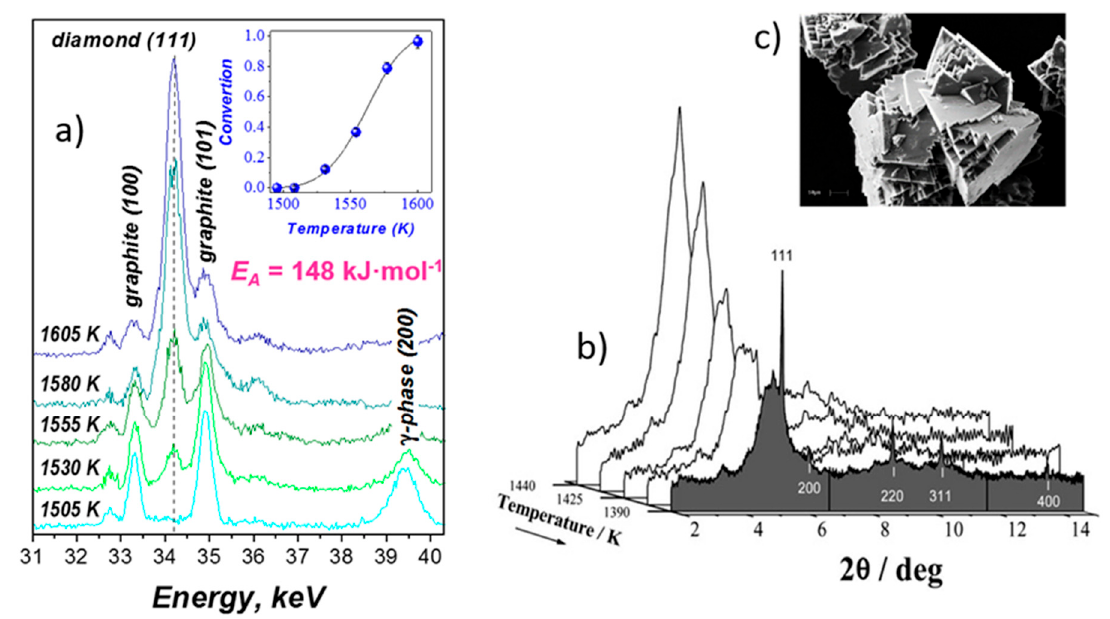
Figure 7. In situ observation of synthesis of diamond and c-BN from their graphitic precursors using a Paris–Edinburgh press at ESRF. ( a ) Graphite-to-diamond transformation in the presence of Fe-Ni-C liquid: energy dispersive X-ray diffraction patterns taken at 5.2 GPa with heating rate 25 K/min [65]. Insert: Kinetic curve of graphite-to-diamond transformation. Temperature changes linear with time, the full curve correspond to ~4 min. ( b ) Crystallization of c-BN from B-N-H supercritical fluid: sequence of angle-dispersive X-ray diffraction patterns taken at 2.1 GPa in the course of cooling the supercritical solution (57 mol.% BN) from 1460 to 1390 K [64]. ( c ) Scanning electron micrograph of as-grown c-BN crystals (2500 × ) (reproduced from [64] with permission from the PCCP Owner